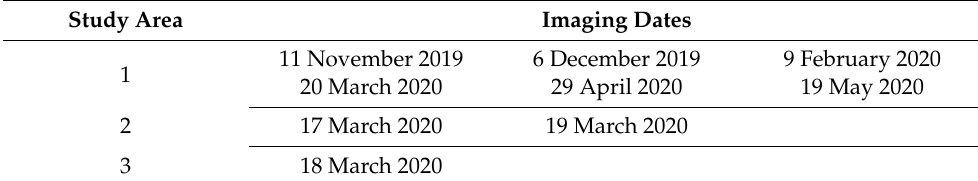
Table 1. Dates of Sentinel-2 images used in the study. Study